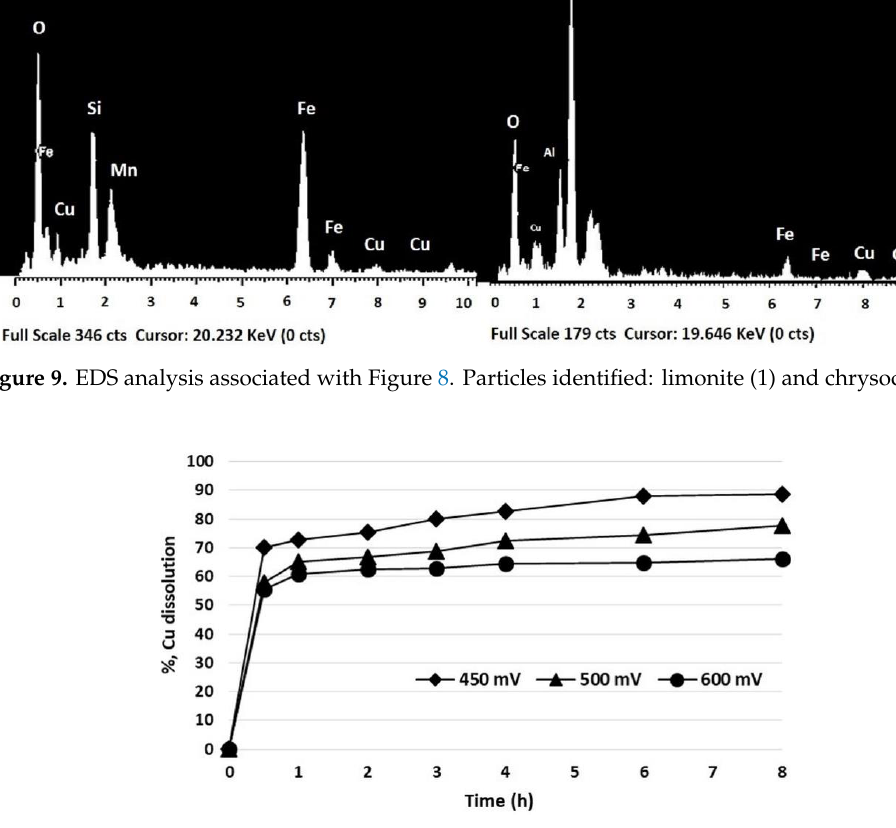
Figure 10. Copper extraction under reducing conditions using FeSO 4 (40 g / L). Solution potential controlled at 450 mV ( (cid:7) ); 500 mV ( (cid:78) ) and 600 mV ( • ), at 25 ◦ C and using 50 g / L H 2 SO